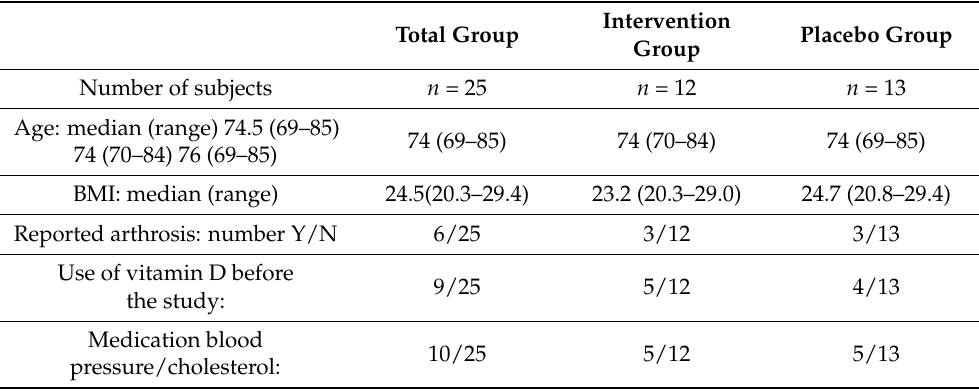
Table 1. Baseline characteristics of the